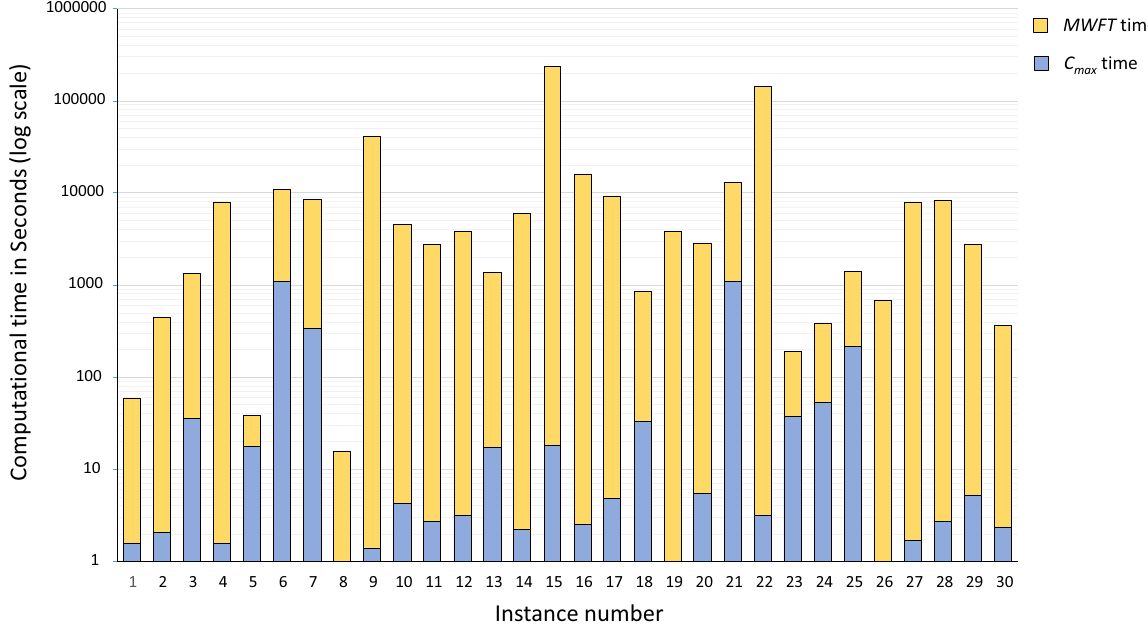
Figure 3. Computational times for the 30